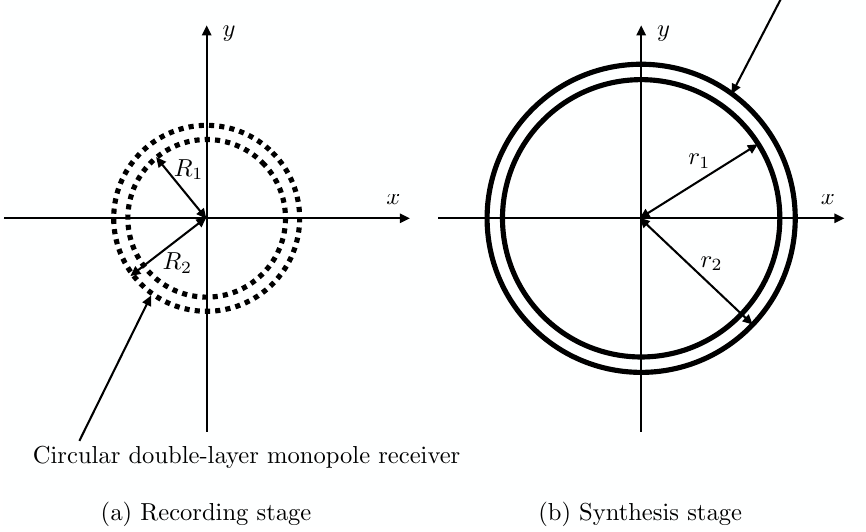
Figure 4. Arrangements: ( a ) circular double-layer monopole receiver for recording a primary sound field; and ( b ) circular double-layer monopole source for synthesizing recorded primary sound field at a secondary